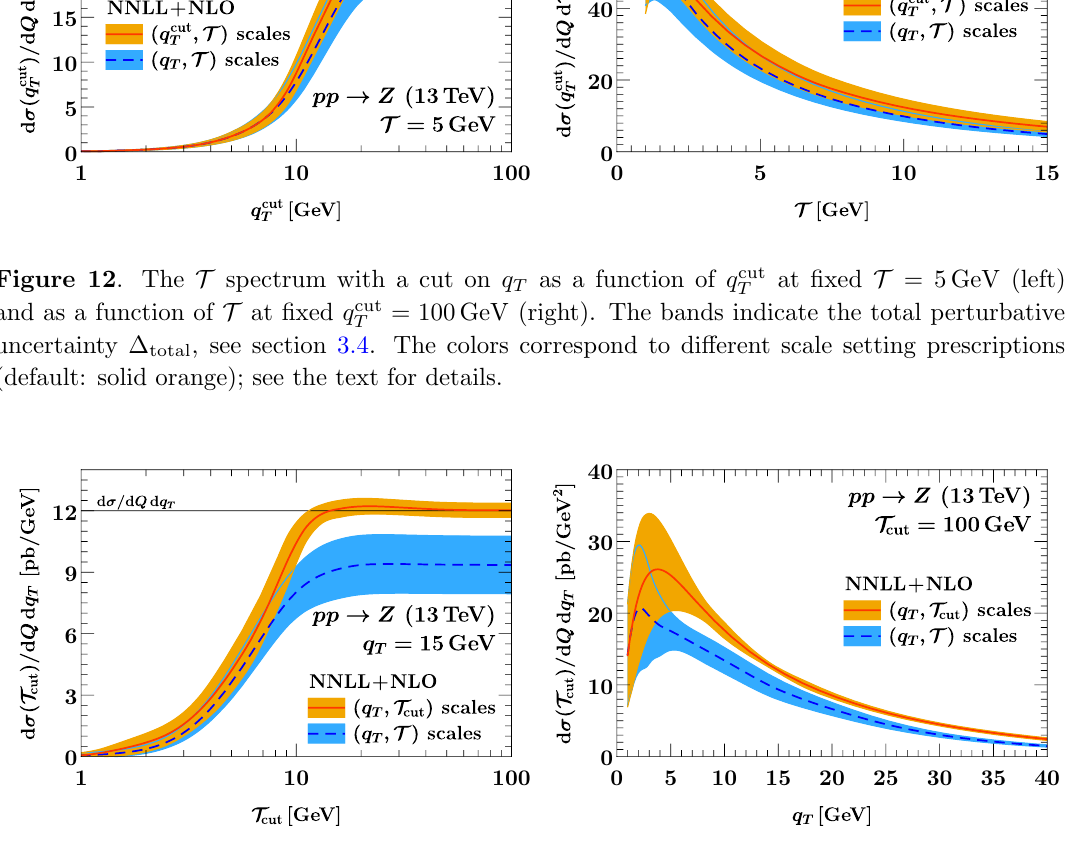
Figure 13 . The q T spectrum with a cut on T as a function of T cut for q T = 15 GeV (left) and as a function of q T for T cut = 100 GeV (right). The bands indicate the total perturbative uncertainty (cid:1) total , see section 3.4. The colors correspond to di(cid:11)erent scale setting prescriptions (default: solid orange); see the text for